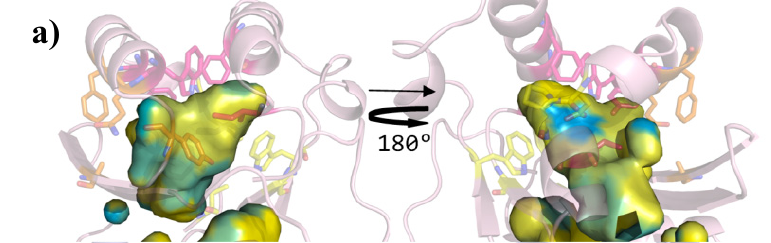
Figure 7. Lipophilic potential of the ligand-binding sites of the QS LuxR and of the prototype of the PAB LuxR solos subfamily. ( a ) TraR (PDB_ID 1H0M [24]) in light pink (showing the side chains of the conserved core in yellow, of the specificity patch in magenta and of the variable patch in orange); ( b ) SdiA (PDB_ID 2AVX [30]) in light blue; ( c ) LasR (PDB_ID 3IX3) in light orange; ( d ) CviR (PDB_ID 3QP1 [29]) in light green; ( e ) QscR (PDB_ID 3SZT [28]) in light yellow; ( f ) OryR model in blue purple. The hydrophobic surface is indicated by yellow and the hydrophilic surface by cyan. Left column: top view (same orientation of the previous Figures); Right column: bottom view (obtained by 180 degrees rotation around y axis). Figures produced by Pymol